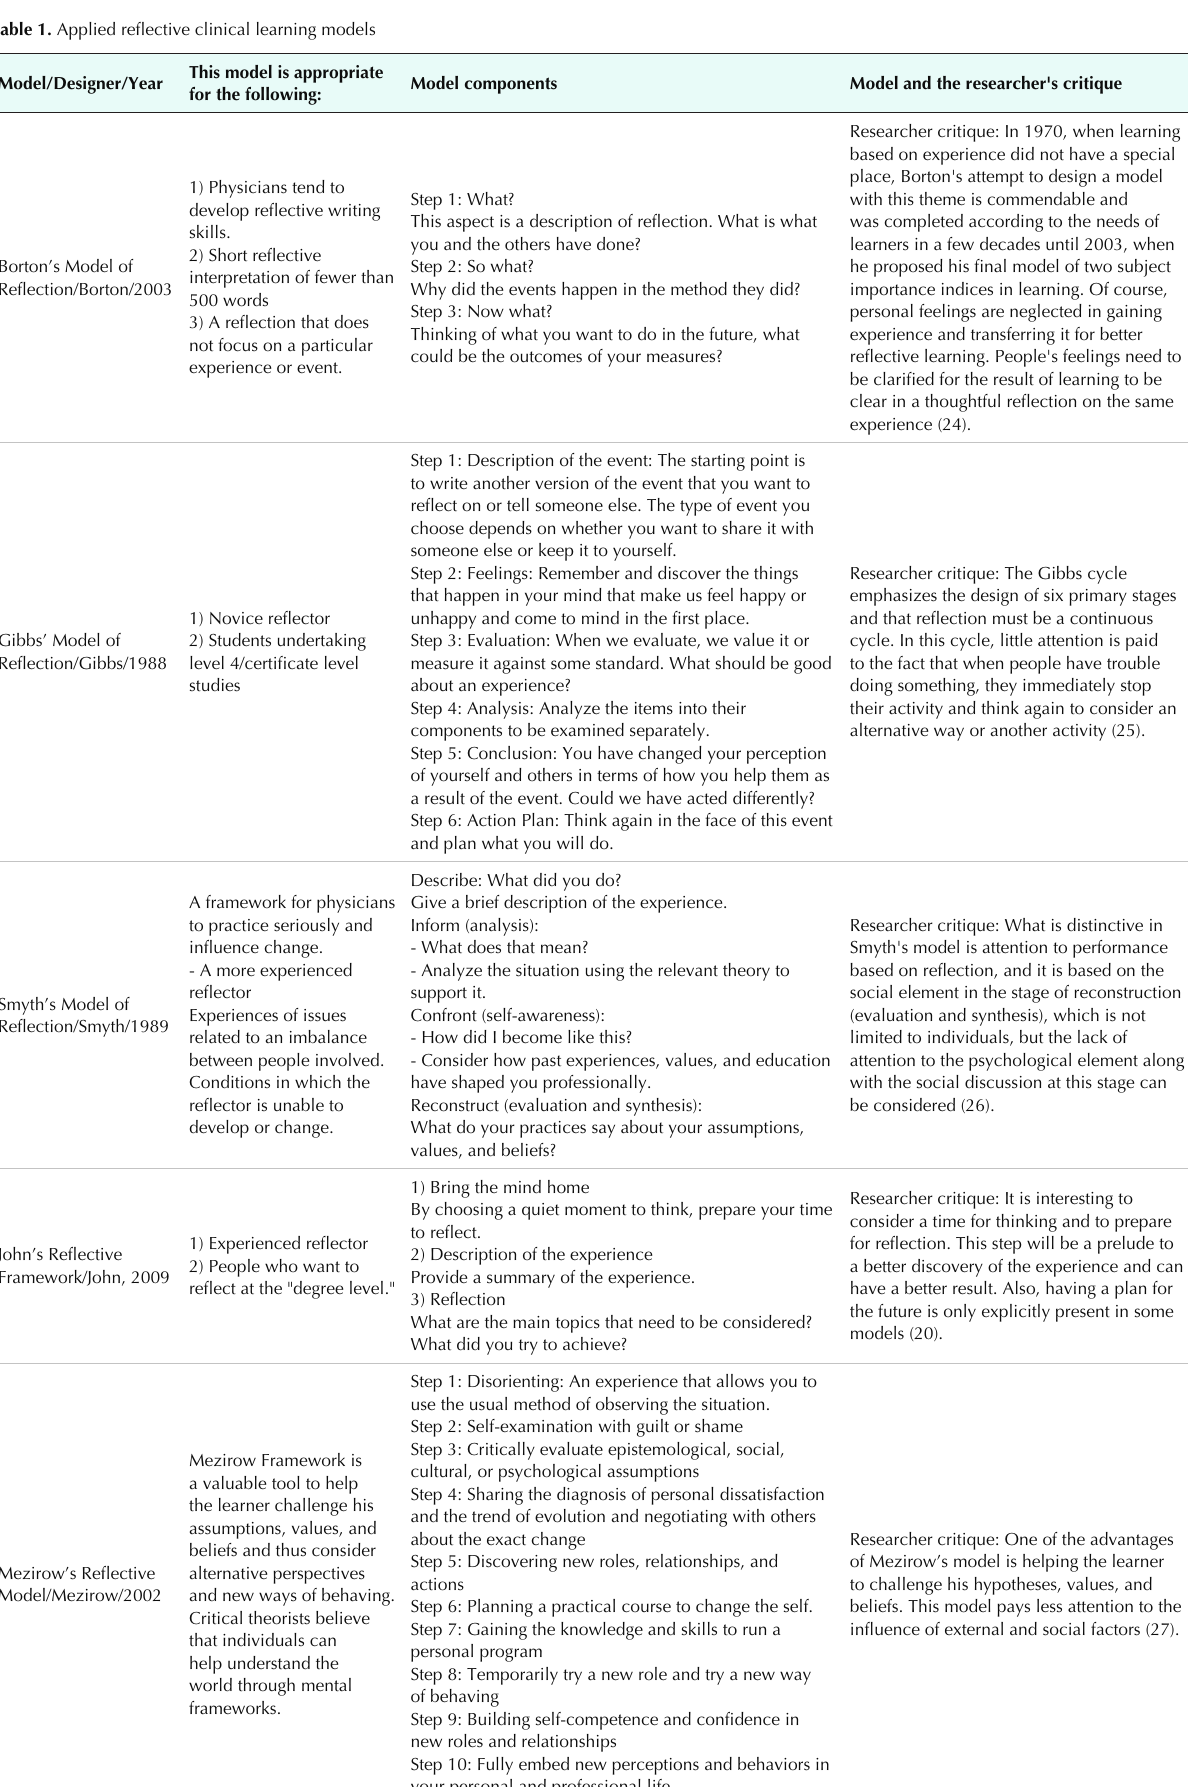
Table 1. Applied reflective clinical learning models